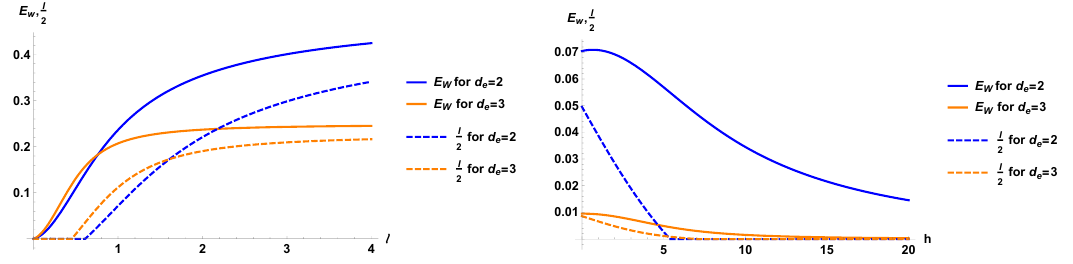
Figure 19 . E W as a function: Left ) of ‘ for h = 0 . 1 and r c = 1 . Right ) of h for ‘ = 10 and r c = 5 . The dashed curves are half of the HMI and the solid curves are E and I by r de − 1 c , where a = R d L d − 1 . a 2 G N r θ F